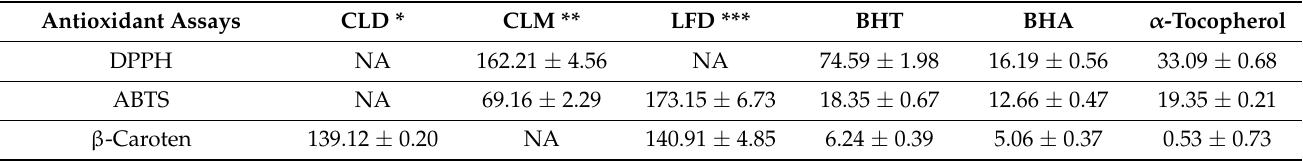
Table 3. IC 50 values of the C. lancifolius extracts (μg/mL). Mean ± SD (n = 3).